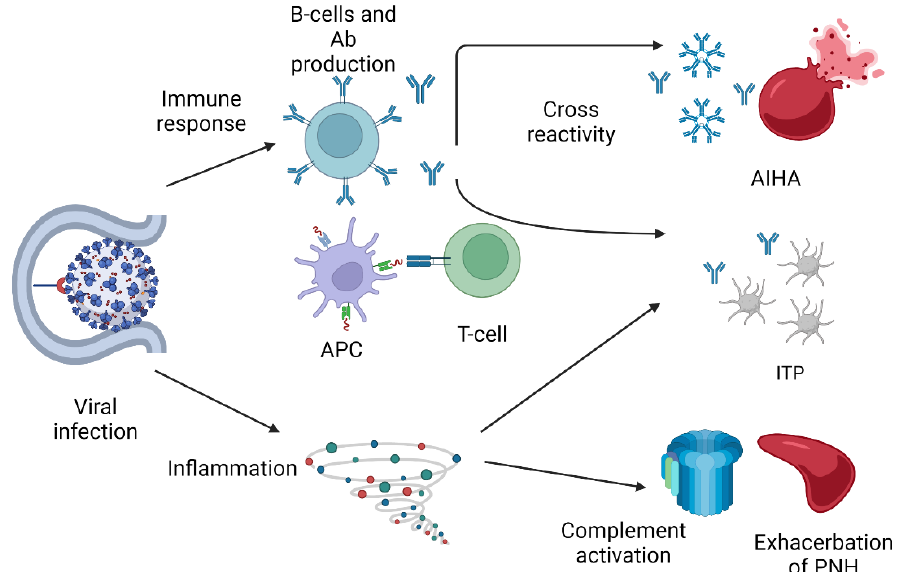
Figure 2. Mechanism of immune-mediated cytopenias triggered by COVID-19 infection. AIHA autoimmune hemolytic anemia, ITP immune thrombocytopenia, PNH paroxysmal nocturnal hemoglobinuria, Ab antibodies, and APC antigen-presenting cell. Figure created with BioRender.